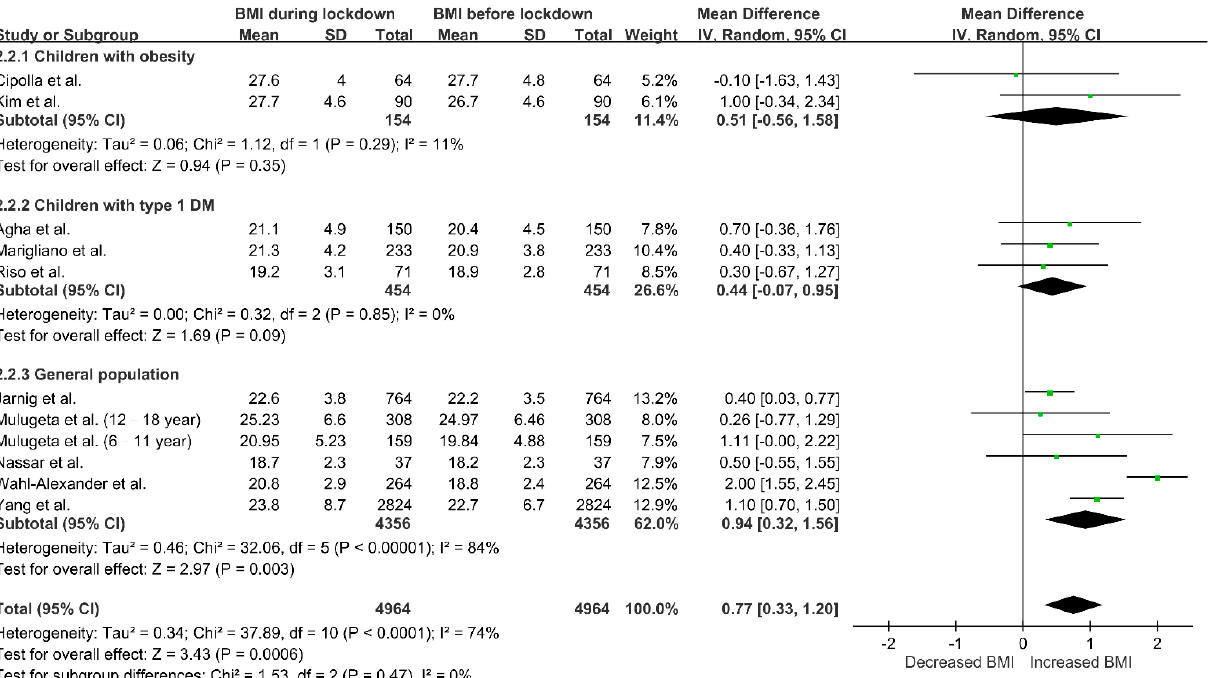
Figure 3. Changes in BMI during lockdown in children. Study populations were further divided into three groups (children with obesity, children with type 1 diabetes mellitus and children without comorbidities), and subgroup analysis was performed. Abbreviations: BMI, body mass index; DM, diabetes mellitus.